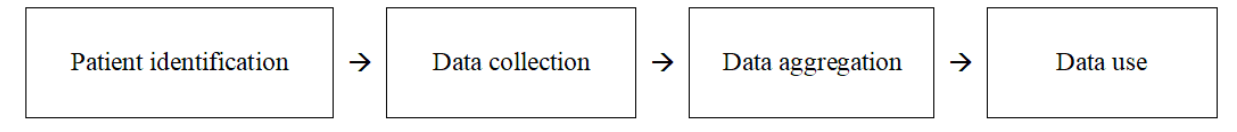
Figure 2. The four processes in the lifespan of patient-related health data (from